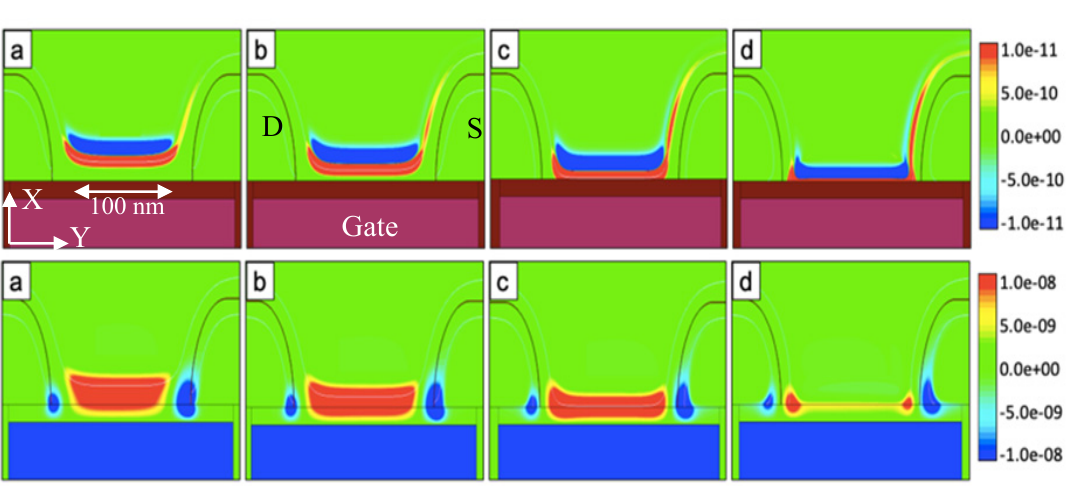
Figure 2. Top row: distribution of DC hole variations (scale bar: cm –3 ). The simulation program does not report hole variations in the gate and in the oxide both treated as ideal. Bottom row: potential distribution (scale bar: V) under 1 mV radio frequency (RF) gate voltage at 1 THz. Bias voltage at the gate: ( a ) V G = 2 V, ( b ) V G = 1 V, ( c ) V G = 0 V, ( d ) V G = − 1 V.